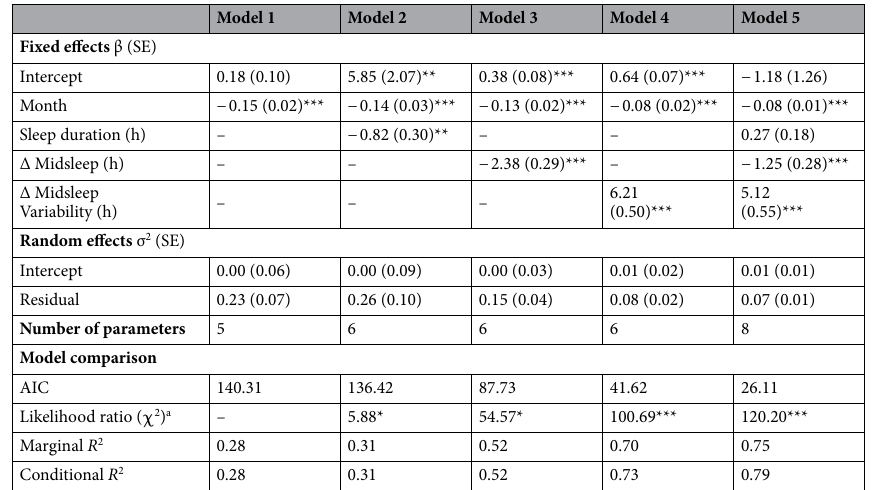
Table 1. Model fit statistics predicting changes in resting heart rate. Unstandardized fixed and random effects and model fit statistics for five multilevel models predicting change in resting heart rate (bpm) from change in sleep patterns. Model 1 represents the baseline model while Models 2–4 included additional predictors for sleep duration (Model 2), change in midsleep time (Model 3) and change in midsleep variability (Model 4) factors. Finally, Model 5 included all three additional predictors to assess the independent contributions of each predictor in the model. SE, standard error; AIC, Akaike information criterion. a Likelihood ratio value is based on comparison to Model 1. * P < .05; ** P < .01; *** P < .001.